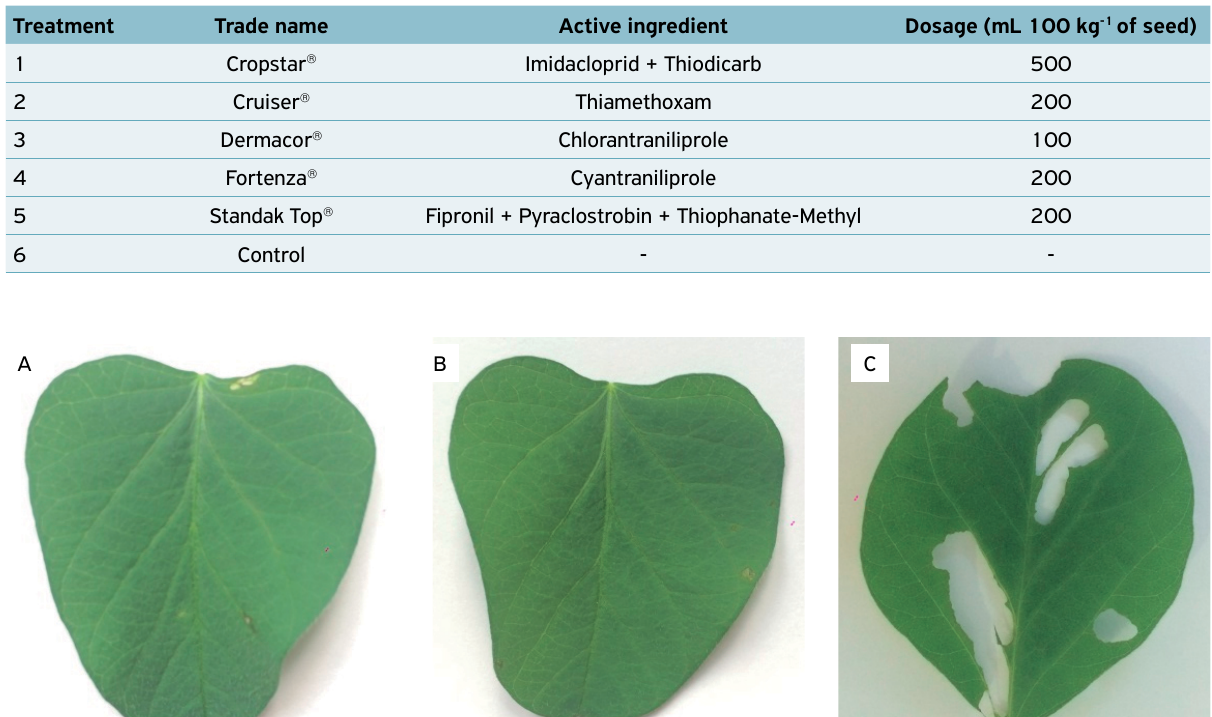
Figure 1. Soybean leaflet after seed treatment with chlorantraniliprole (A) and cyantraniliprole (B) and control without treatment (C).